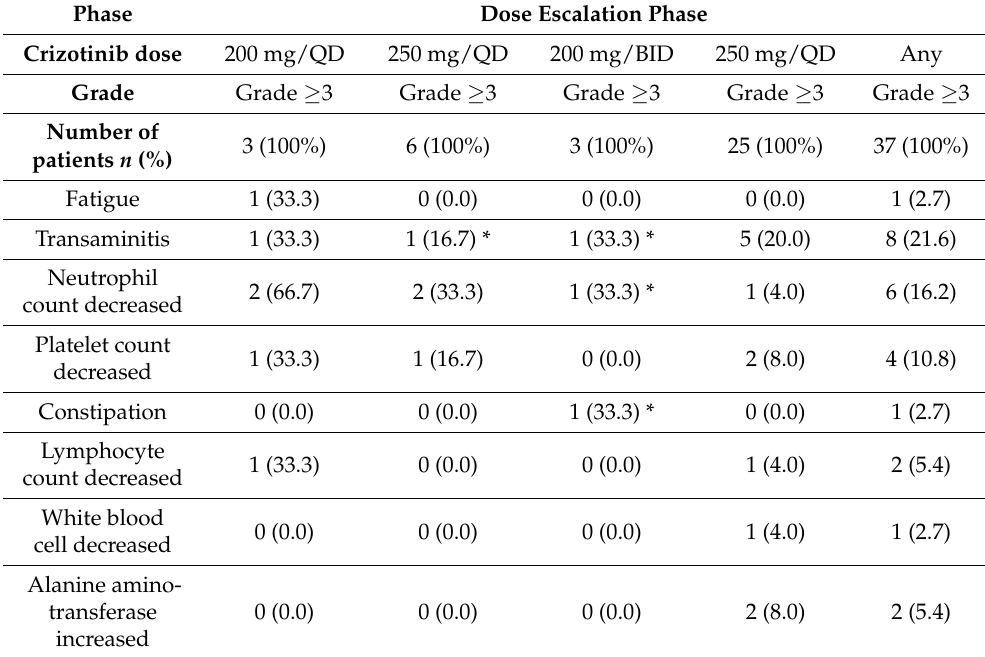
Table 2. Grade ≥ 3 treatment-related adverse events classified by study phase, crizotinib dose, and